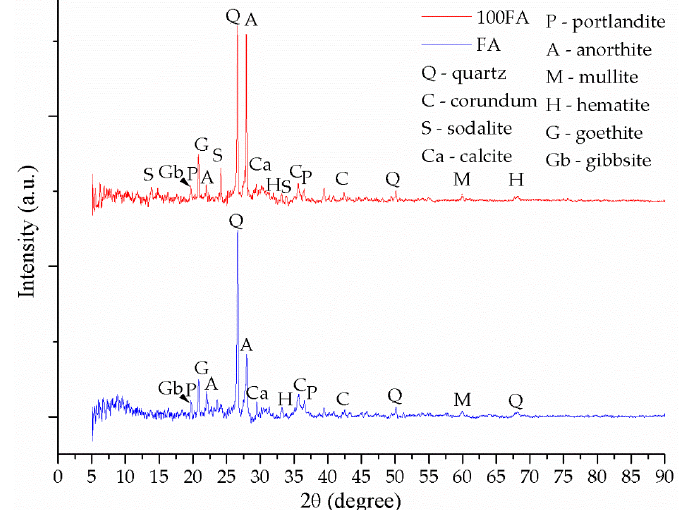
Figure 7. XRD patterns of fly ash powder and sample 100FA. (the Gb and P peaks with the highest intensity are overlapping).